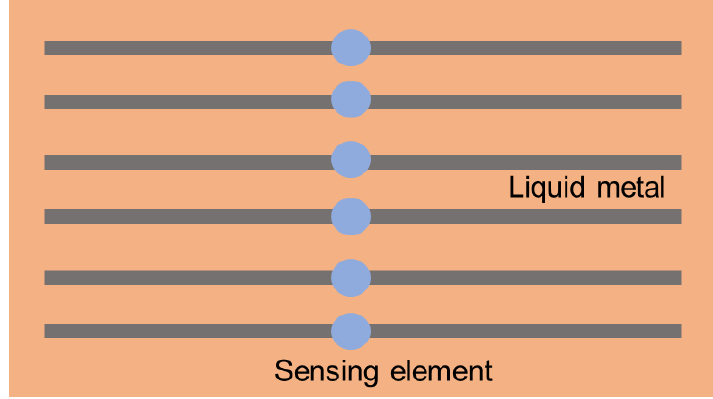
Figure 6. Illustration of circuits using liquid metal as soft connection.